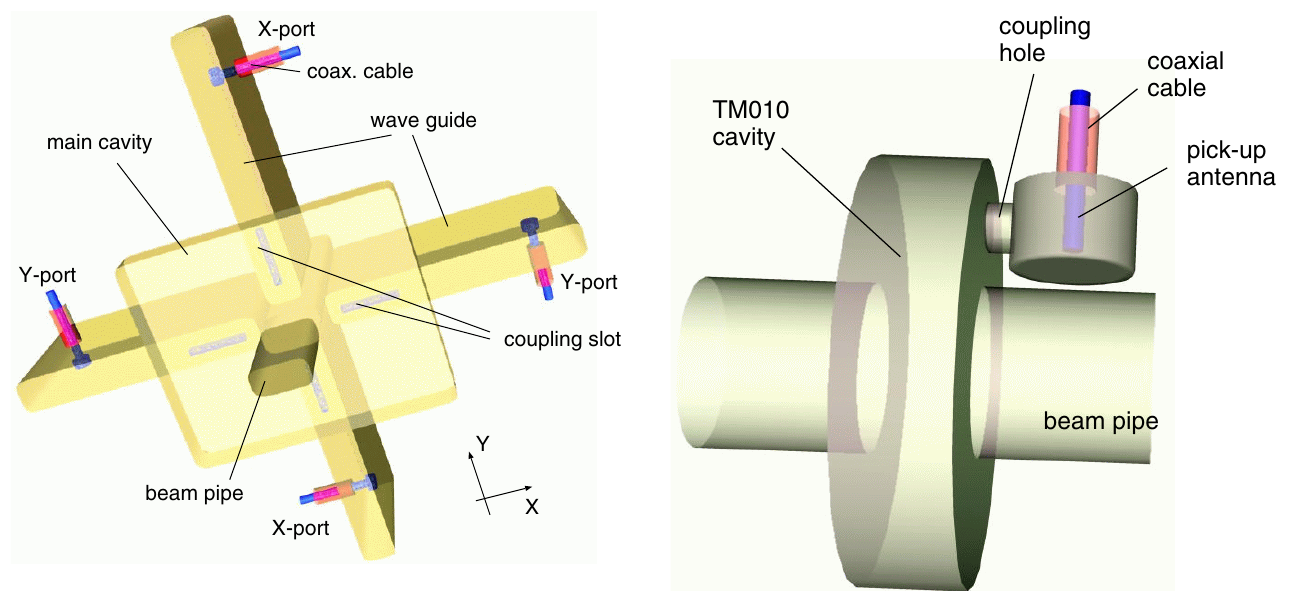
FIG. 3. (Color) Structure of the BPM cavity.